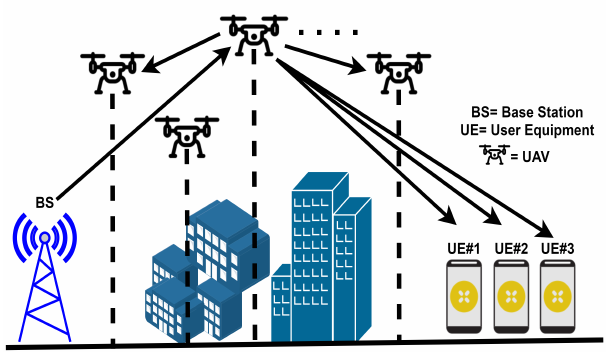
Figure 1. A cooperative UAV-enabled relay